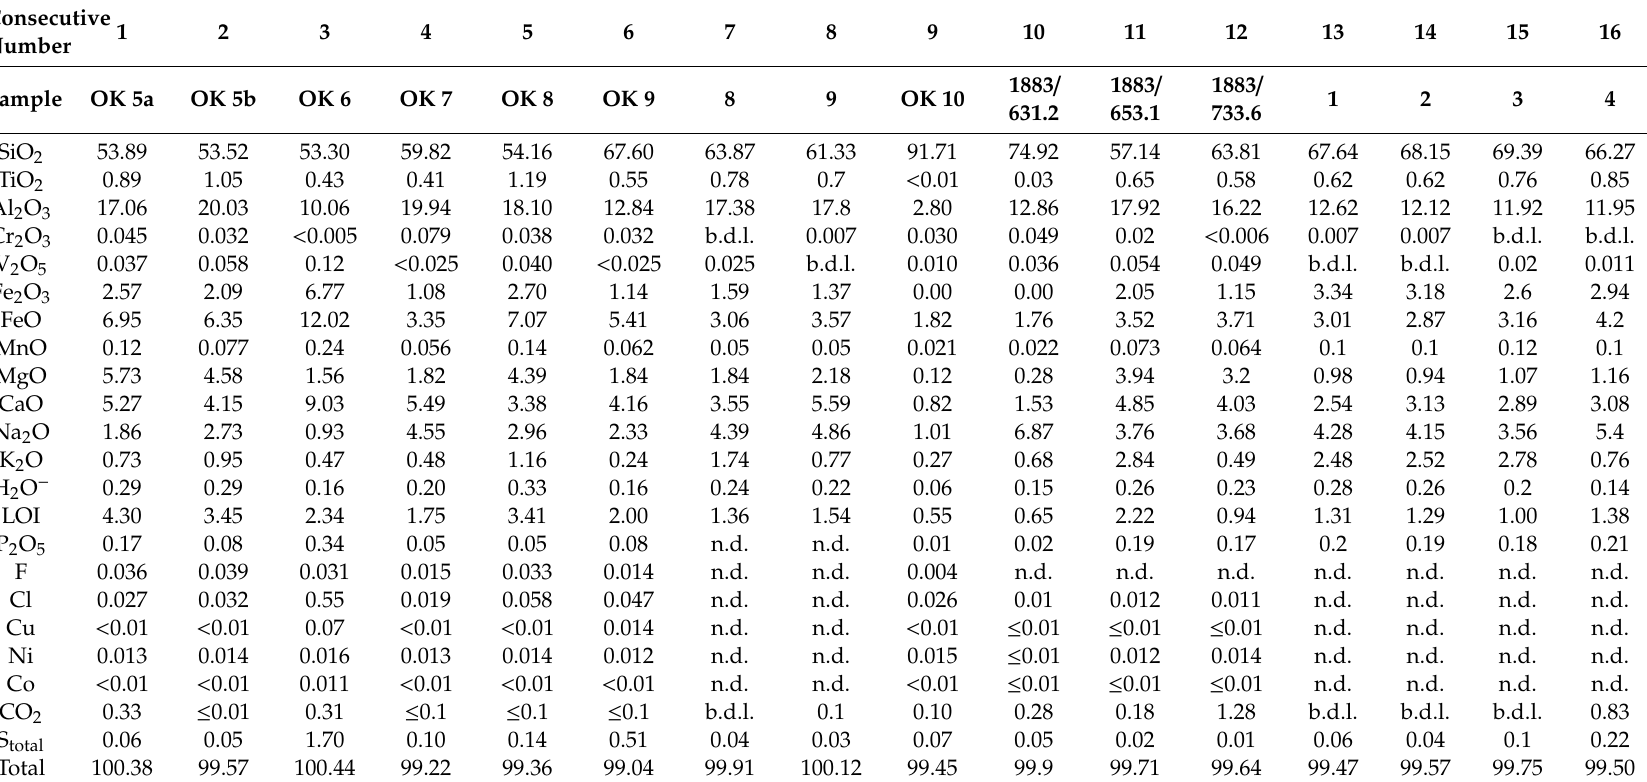
Table 4. Chemical composition of rocks of the DW block, borehole 1883, and Gabbro-10 massif (wt